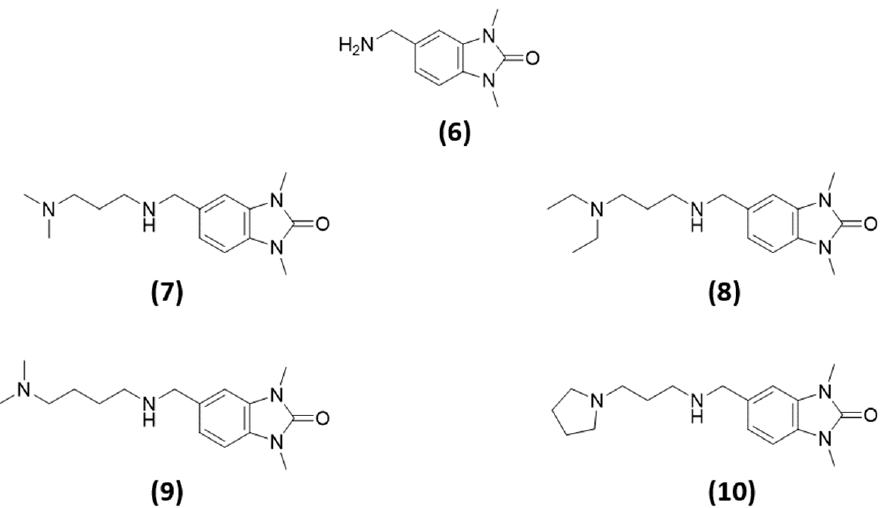
Figure 8. Chemical structures of the putative ligands of TRIM33, selected according to the scaffold- repurposing strategy.